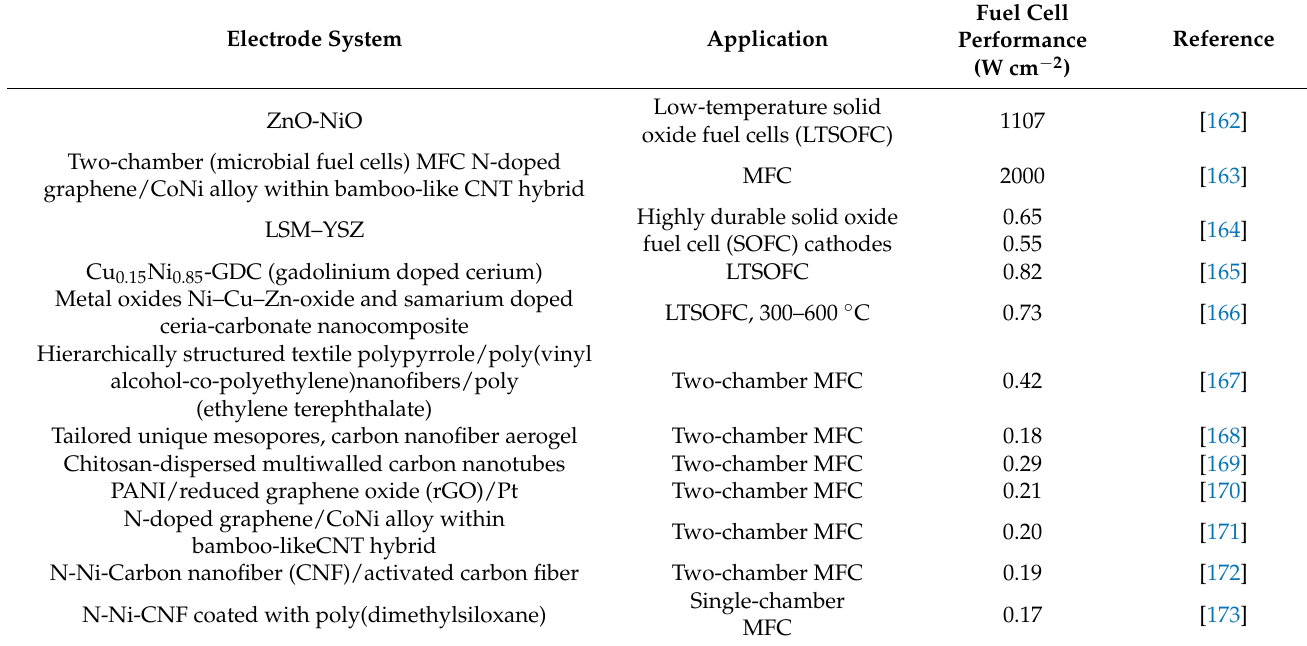
Table 5. Various application of nanocomposites in fuel